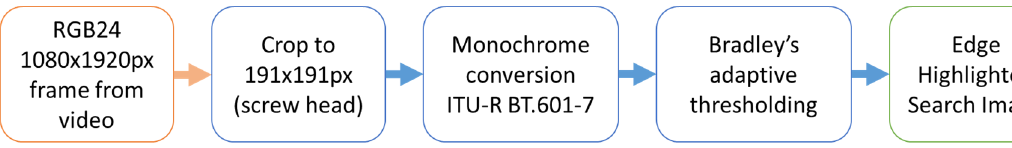
Figure 5. Preprocessing scheme.